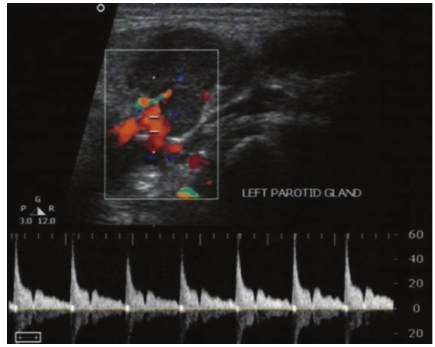
Figure 5: Colour doppler spectral waveform within the intrale- sional flow shows arterial type of flow with relatively high